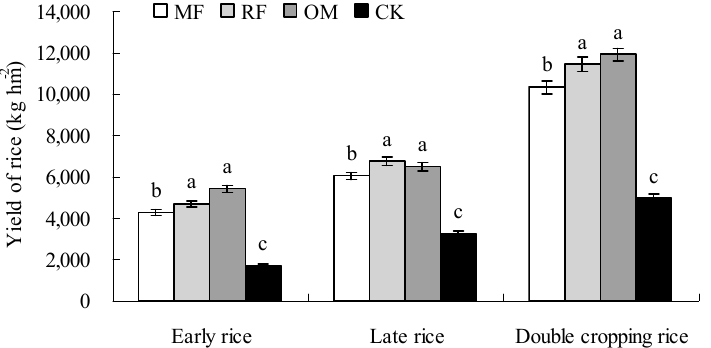
Figure 5. Effects of different long-term fertilizer treatments on yields of early rice and later rice in the double-cropping rice system. Different lowercase letters indicate significant differences ( p < 0.05) among different fertilizer treatments.